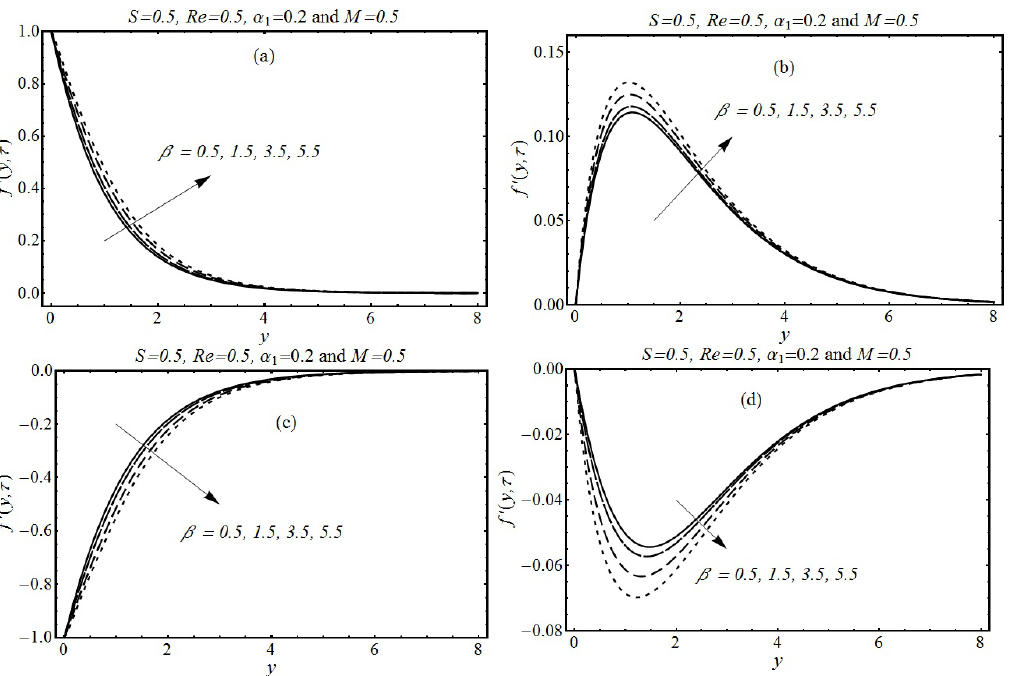
Figure 7: Effects of β on velocity profile (a) τ = 8.5 π , (b) τ = 9 π , (c) τ = 9.5 π , (d) τ = 10 π .